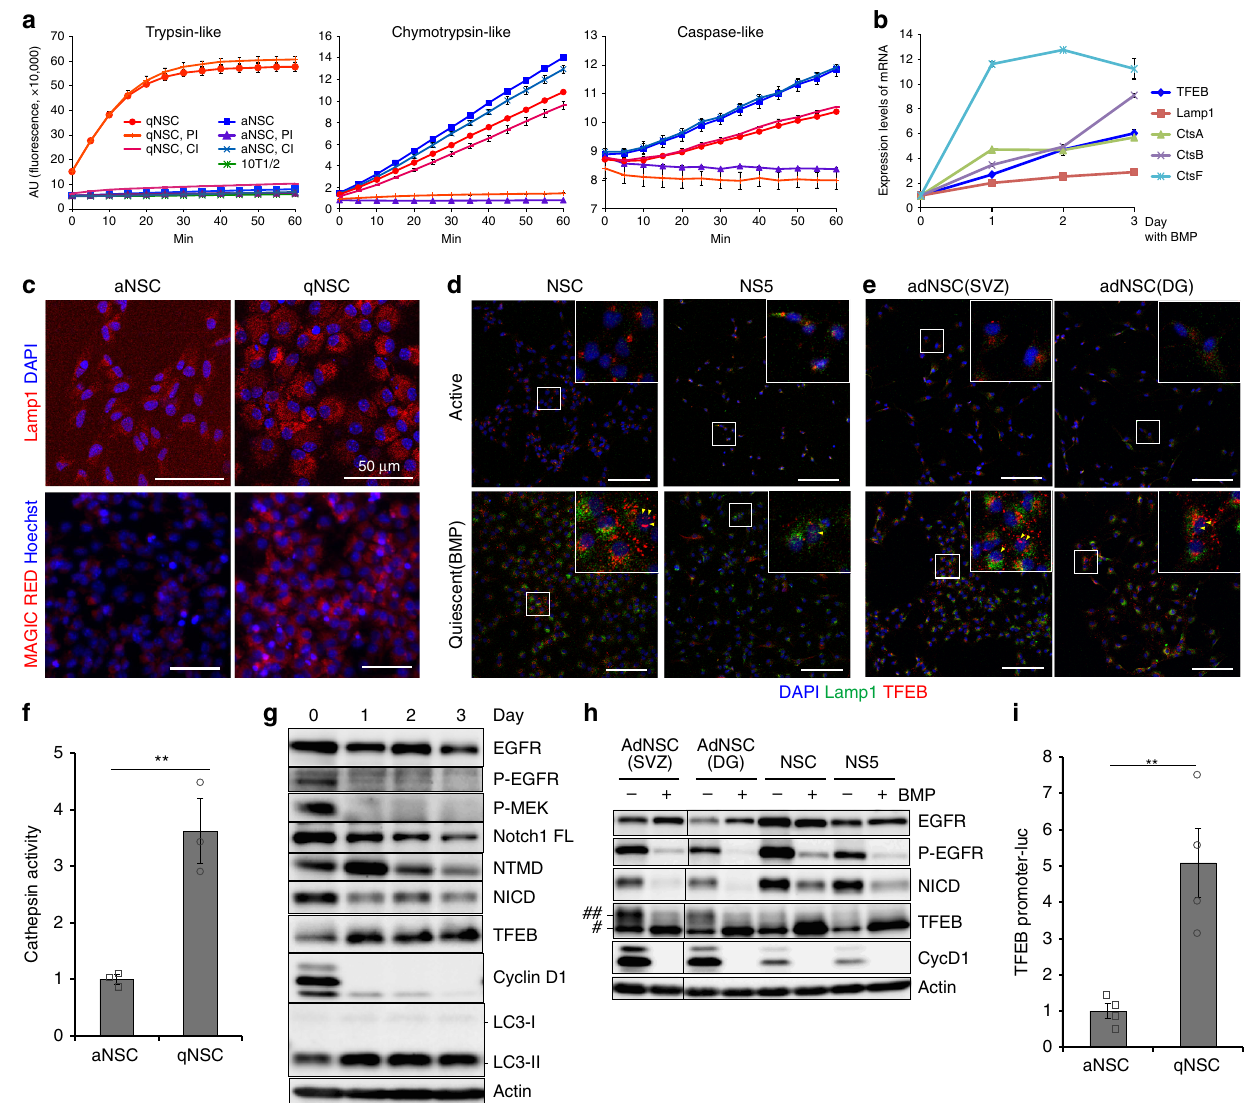
Fig. 1 Increased lysosomal activity in qNSCs in vitro. a Peptidase activities in NSCs. Trypsin-like, chymotrypsin-like, and caspase-like activities in NSC lysate were continuously measured every 5 min for 1 h, with or without proteasome inhibitor (PI) or cathepsin inhibitor (CI); n = 2. b qPCR of the lysosomal genes: Lamp1 and cathepsins (CtsA, CtsB, and CtsF), and the transcriptional regulator TFEB, after BMP exposure. c Immunocytochemistry of Lamp1 (red) with DAPI (blue) (upper panels). Staining of Magic Red cathepsin L (red) and Hoechst 33342 (blue) (lower panels). Scale bars, 50 µ m. d , e Immunocytochemistry of Lamp1 and TFEB in the active and quiescent states induced by BMP in NSCs, NS5 cells ( d ) and adult NSCs ( e ). Selected regions indicated by white squares are enlarged. Yellow arrowheads in enlarged squares indicate nuclear localization of TFEB in the quiescent state. Scale bars, 100 µ m. f Lysosomal cathepsin L activity in NSCs, as determined using Magid Rred cathepsin L; n = 3. Corresponding data points were plotted. g Immunoblots of signaling molecules in NSCs after BMP exposure. β -Actin was used as a loading control. h Immunoblotting of several NSC lines in the active and quiescent states. Phosphorylated (##) and dephosphorylated forms of TFEB (#) were detected. i Reporter assay of TFEB-promoter – driven luciferase; n = 4. Data represent means± s.e.m. (** P < 0.01; Student ’ s t- test). Source data of immunoblots are provided as a Source Data fi